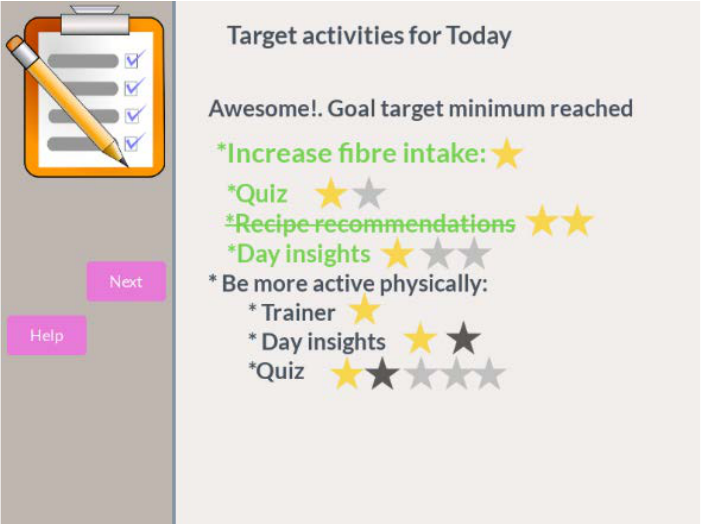
( b ) Figure 15. Preview target activities next week and reminder for next week. ( a ) See the target activities for next week; ( b ) reminder for next week’s coffee. 4.1.2. Motivational Day Agenda The day agenda is an intervention tool which shows the set of target interventions to be carried out during the day. It does not set a specific time to do them (rationale explained in Section 3.3.3: Momentary planning). This tool is launched the first time the participant is detected every day.